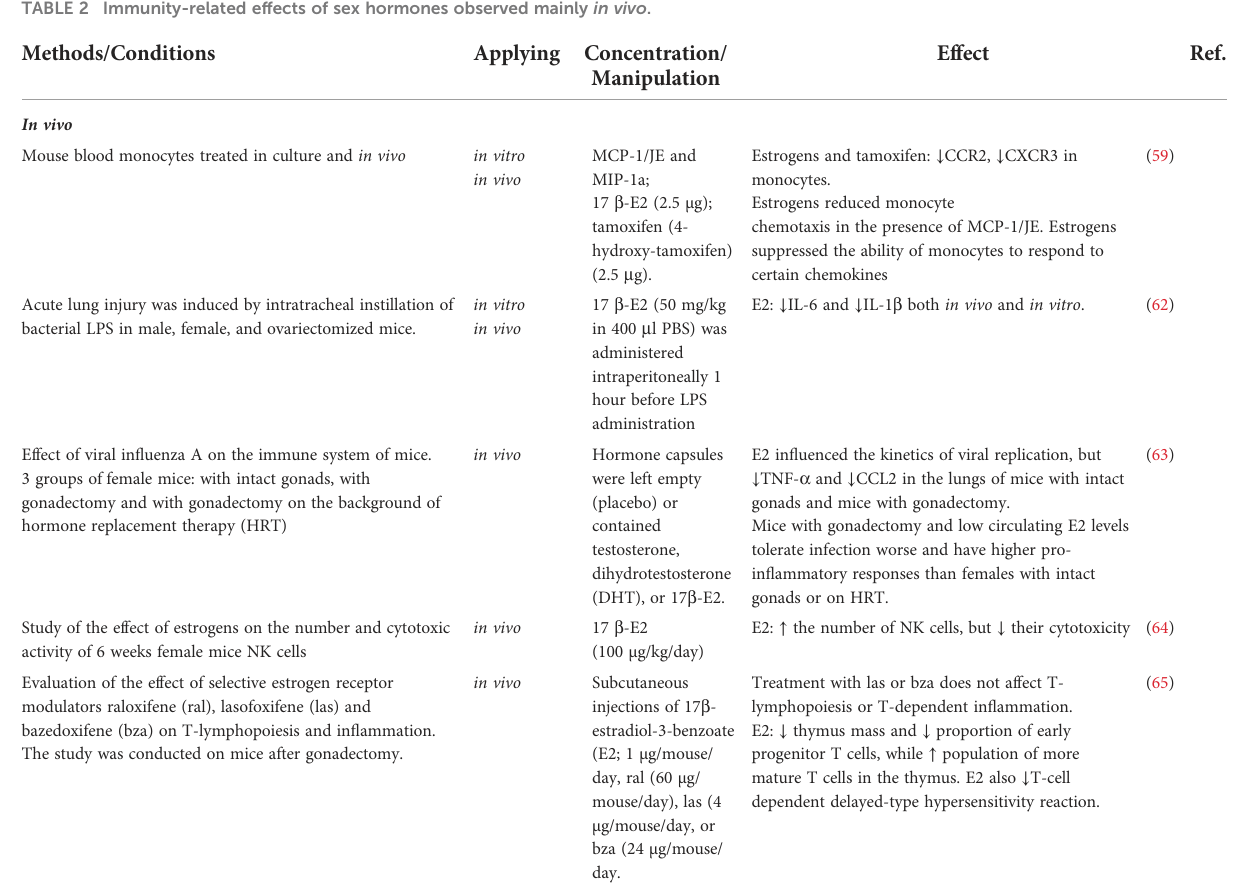
TABLE 2 Immunity-related effects of sex hormones observed mainly in vivo